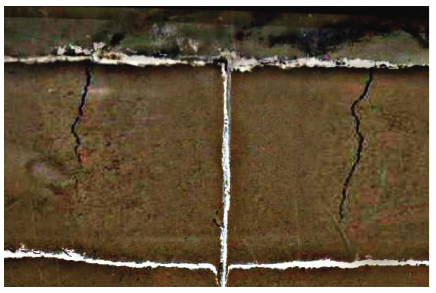
Figure 6: Vertical